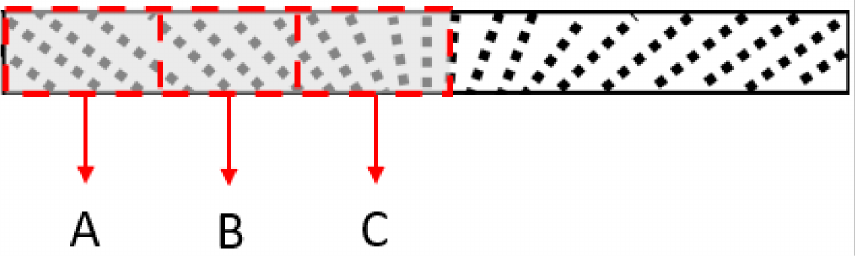
Figure 11. TheillustrationofRegionsA,BandCofcross-sectionMREsampleundermorphological analysis.